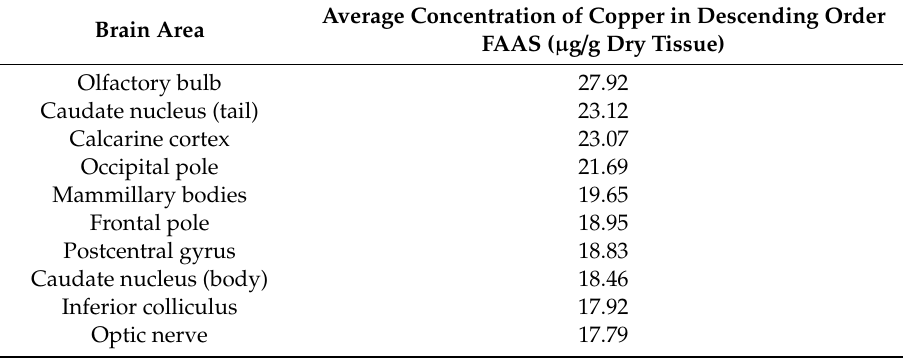
Table 2. Average concentration of copper in di ff erent brain areas